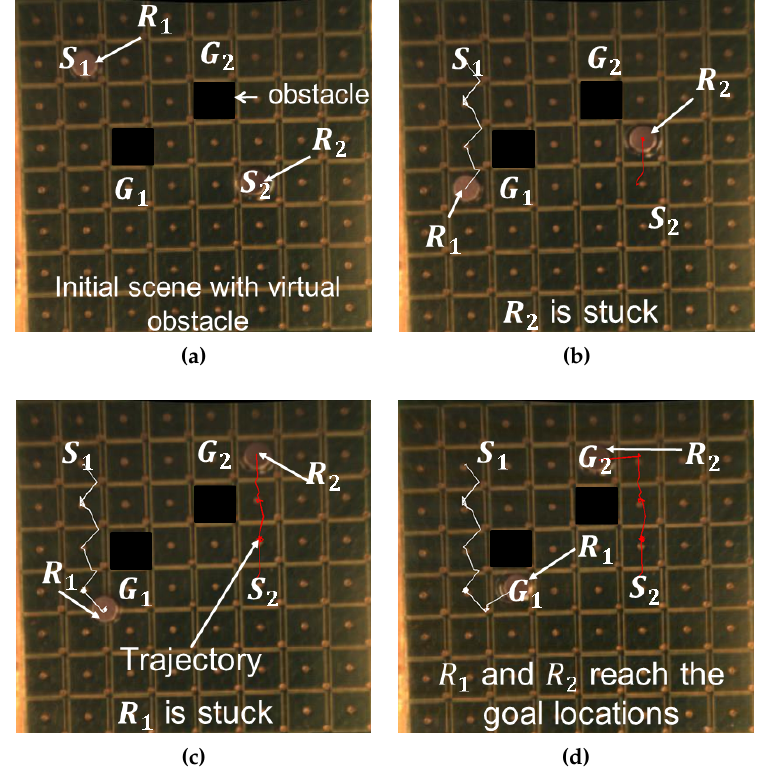
Figure 8. Autonomous independent navigation of two robots towards respective goal locations on an array of 64 microcoils: ( a ) Initial scene with the robots and the goal locations; ( b ) The first robot reaches a waypoint whereas the second robot is stuck due to uneven friction on the surface; ( c )The second robot overcomes the friction to move towards the goal location whereas the first robot got stuck; ( d ) Both the robots reach their goal locations. The trajectories followed by the robots R 1 and R 2 are marked by white and red lines,